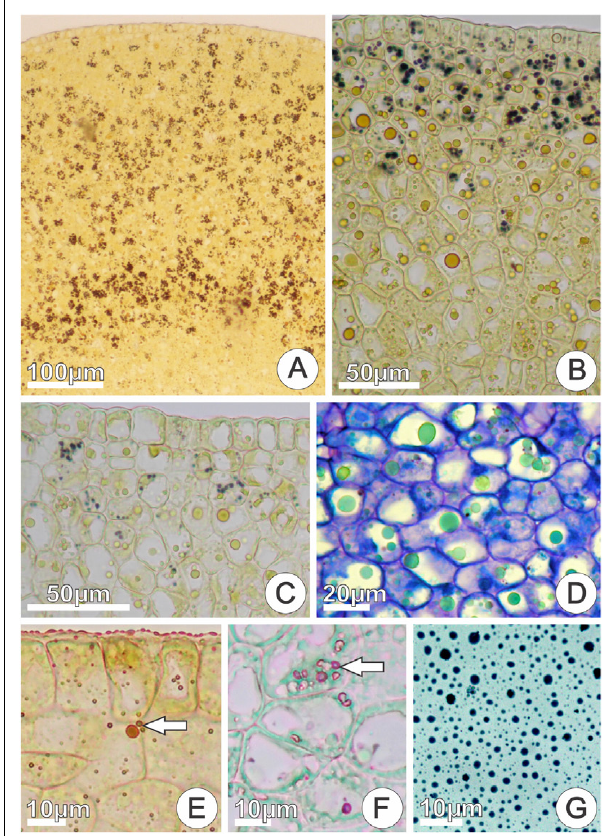
FIGURE 7 | In situ location of the main classes of the chemical compounds detected in cross sections of nectariferous disks and in nectar of Jacaranda oxyphylla flowers. (A–C) Positive reaction to Lugol’s iodine showing progressive depletion of starch grains during anthesis (0, 24, 48 h flowers, respectively); (D) phenolic inclusions (in green) with toluidine blue staining (48 h flowers); (E) positive reaction to Sudan IV for lipids (arrow) (48 h flowers); (F) positive reaction to NADI’s reagent for essences (arrow) (48 h flowers); (G) positive reaction for lipids in raw floral nectar with Sudan Black B (48 h flowers).